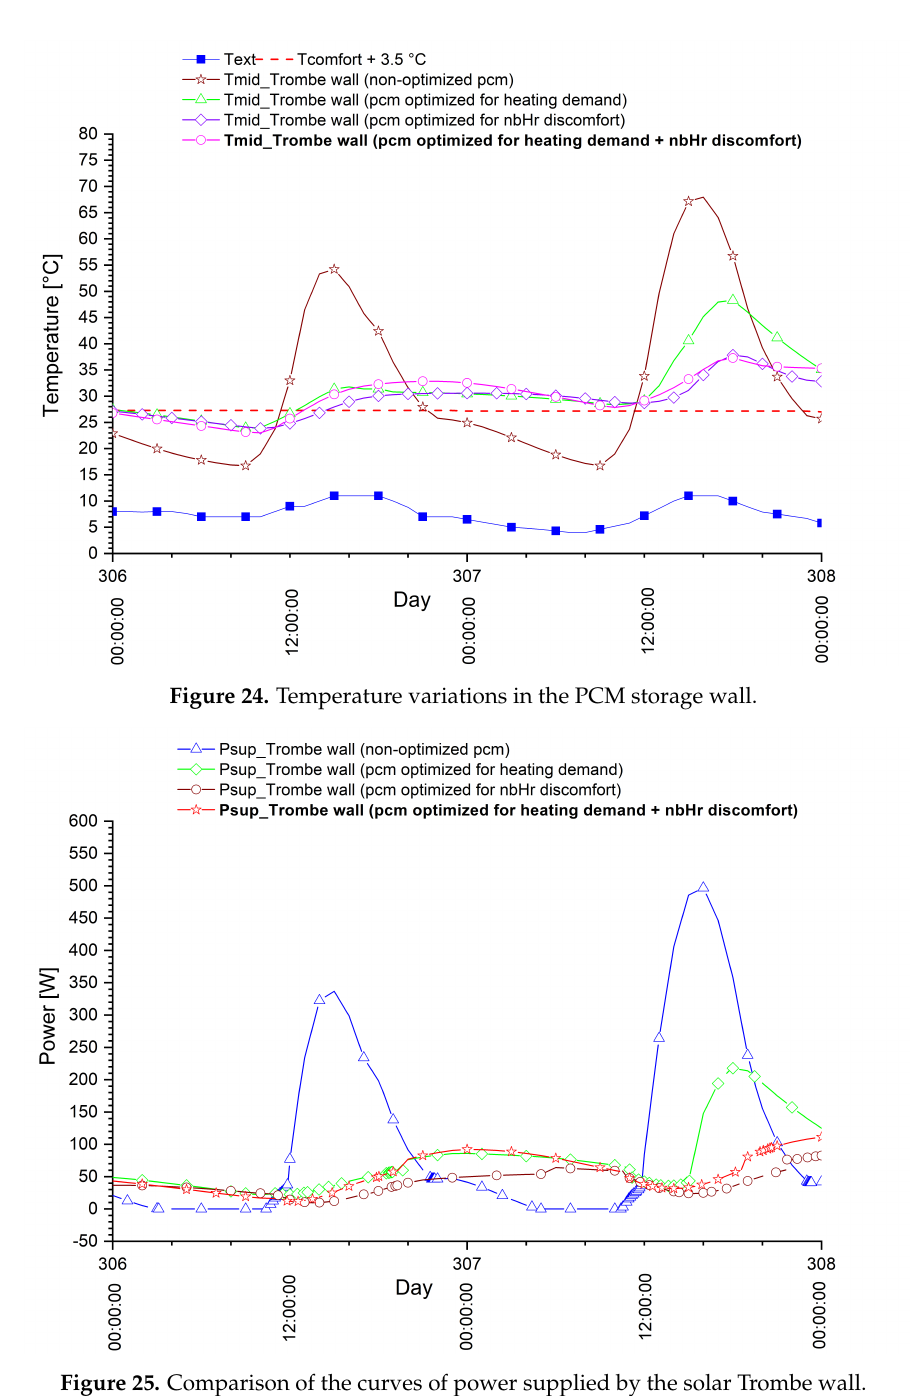
Figure 25. Comparison of the curves of power supplied by the solar Trombe